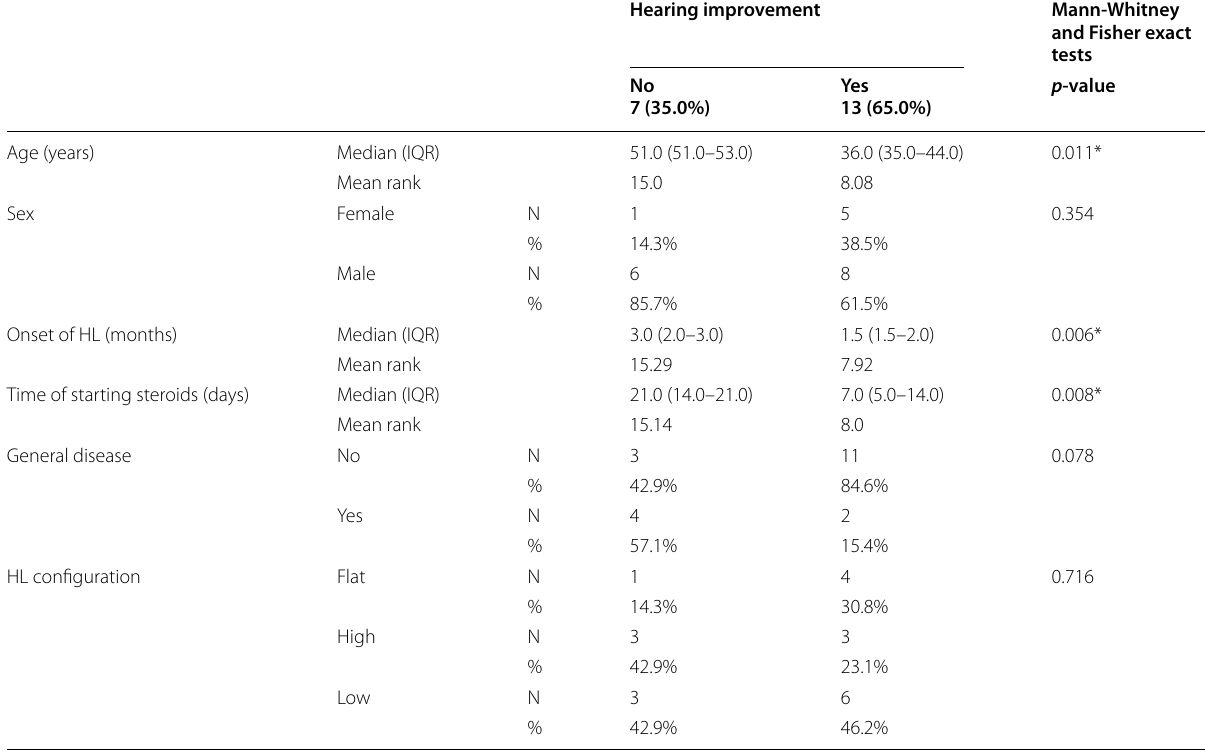
*Significant at P <